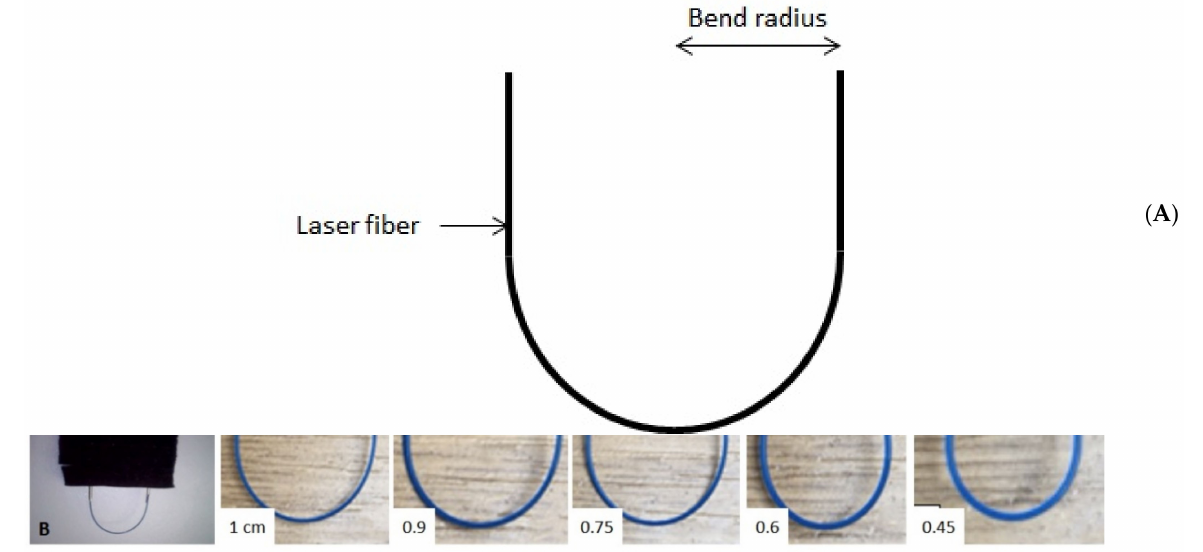
Figure 1. ( A ) Fiber bending radius, ( B ) Fiber bending radii